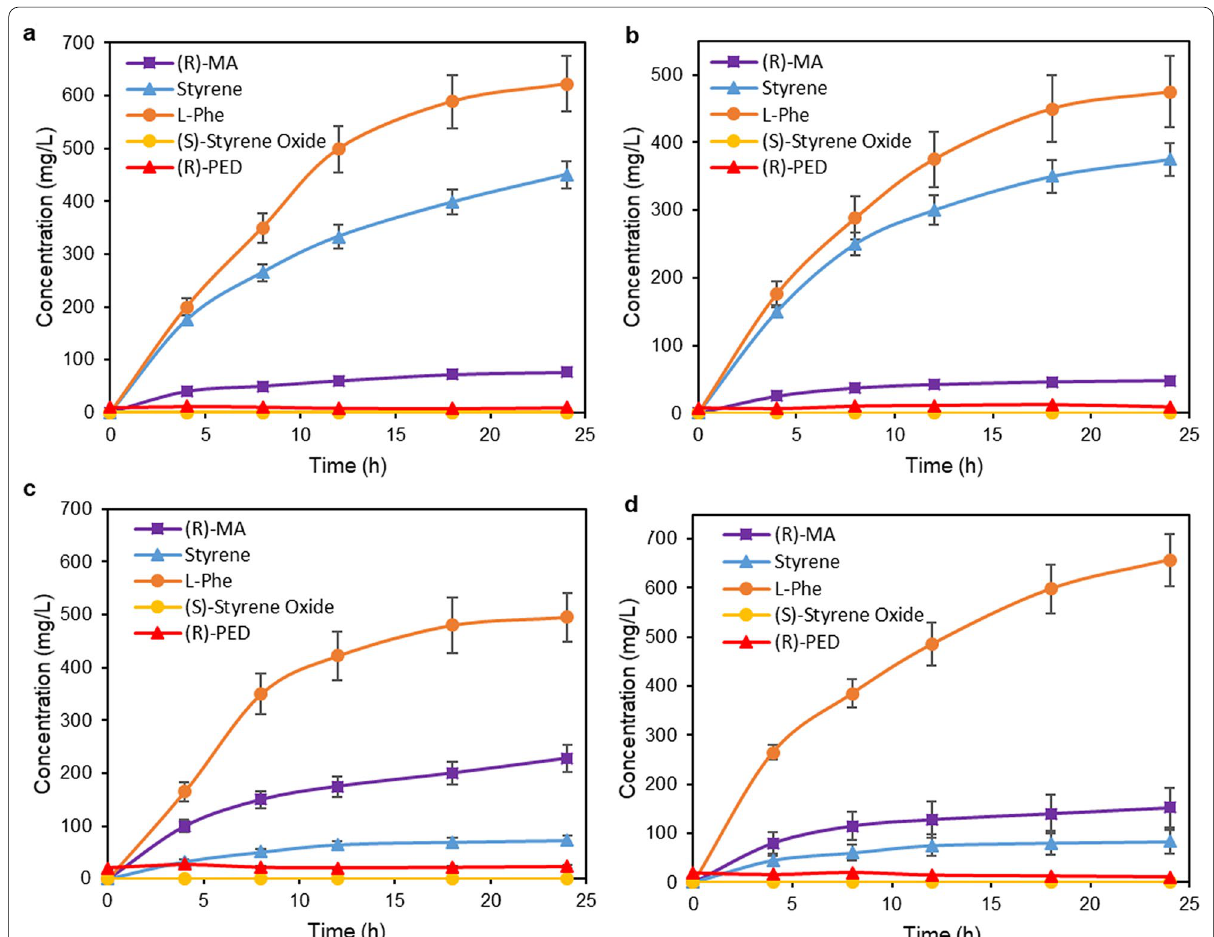
Fig. 3 Time course of producing ( R )-MA from glycerol or glucose with E. coli NST74 (P2S2A) at 25 °C. a Fermentation from glycerol in a single aqueous phase system. b Fermentation from glucose in a single aqueous phase system. c Fermentation from glycerol in n- hexadecane-aqueous phase system (1:2; v/v). d Fermentation from glucose in n- hexadecane-aqueous phase system (1:2;